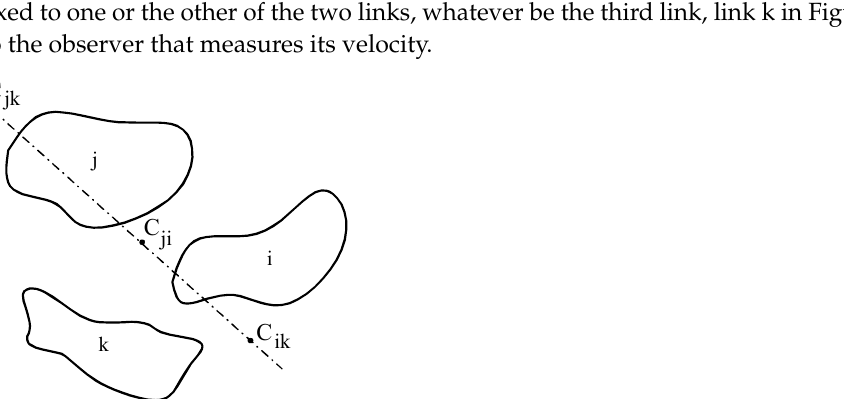
Figure 1. Diagram of the Aronhold-Kennedy theorem.